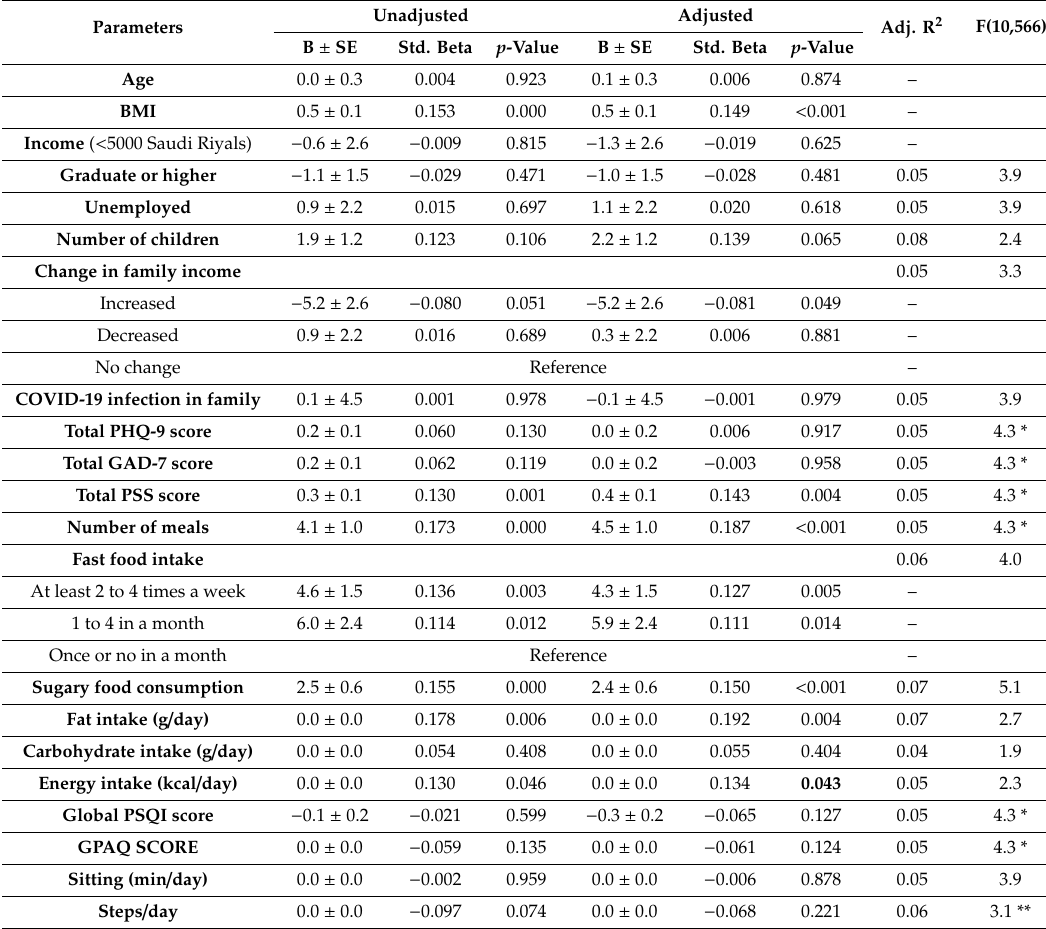
Table 4. Indicators and Predictors of EES score among young women during mandatory